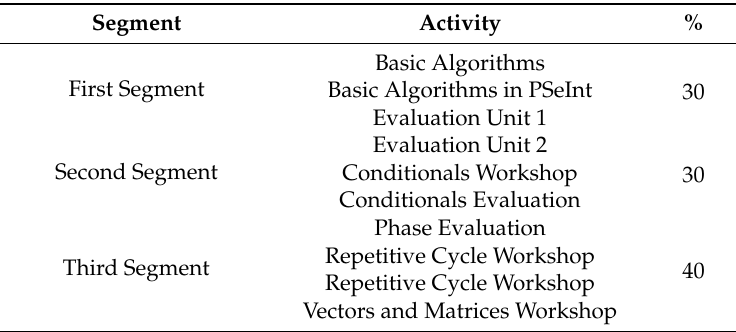
Table 1. Activities conducted in each segment.